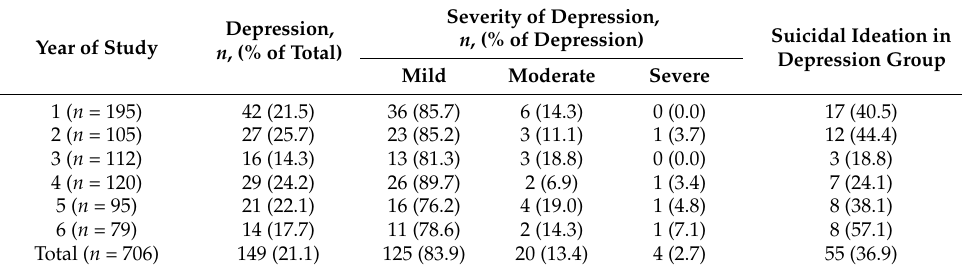
Table 2. Severity of depression according to year of study.